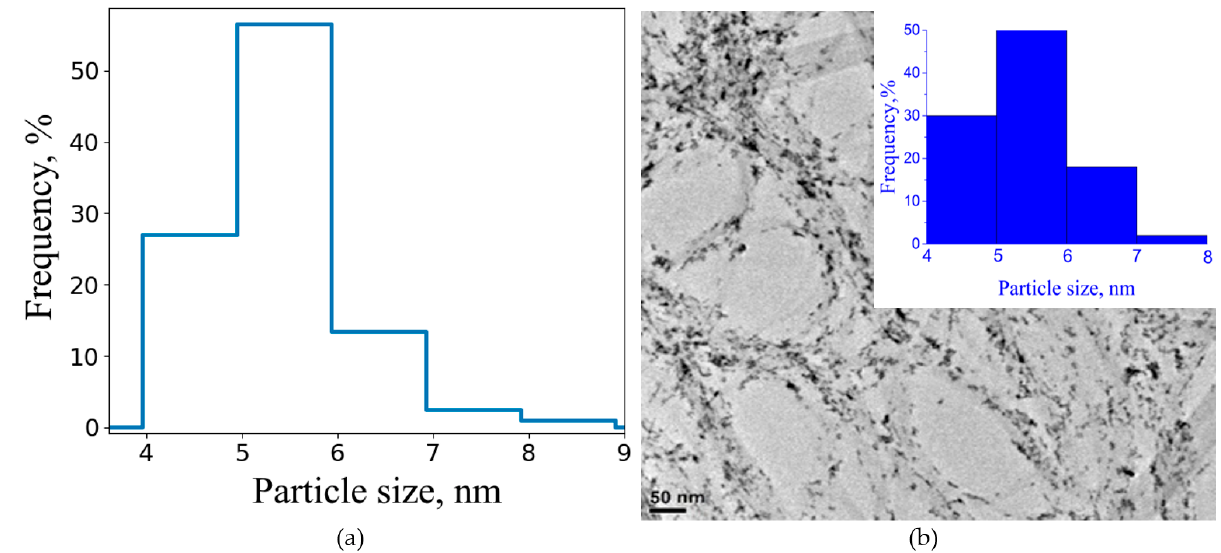
Figure 3. Simulated size distribution of platinum nanoparticles ( a ) and distribution obtained from the TEM image of the Pt/CNT sample ( b ).